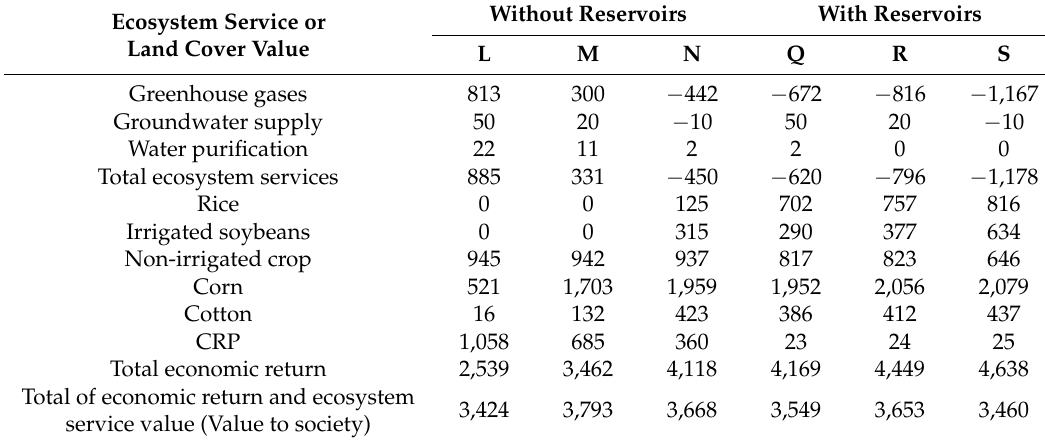
Table 3. Present value of economic returns and ecosystem services for select points on the efficiency frontier optimizing groundwater buffer value (in millions of 2013 constant